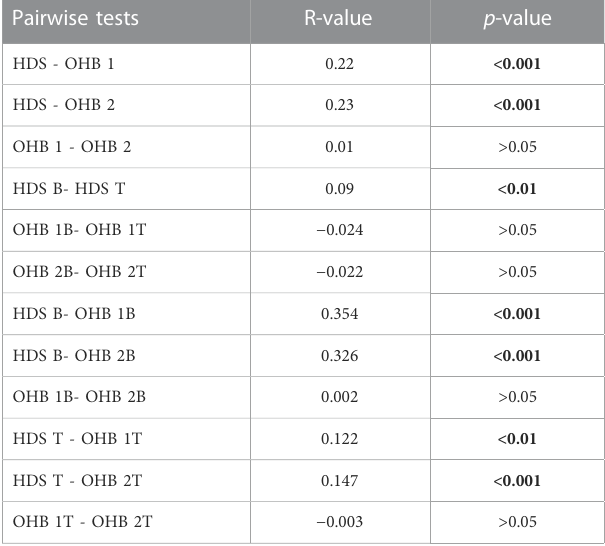
TABLE 4 Results of multivariate comparisons of the assessed spawning grounds in the Ottheinrichbach (OHB) and the groundwater-in fl uenced hinterland draining system Längenmühlbach (HDS) with ANOSIM considering T, top compartment as well as B, bottom compartment of the HEST. Values in bold indicate statistically signi fi cant